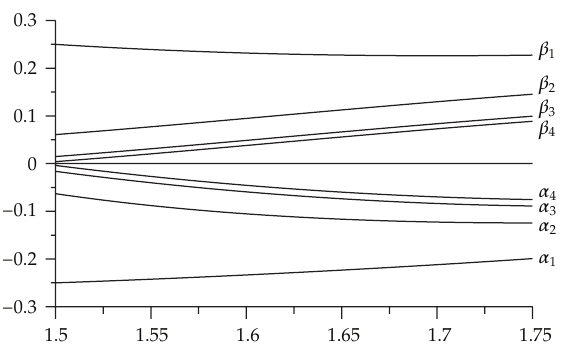
Figure 1: (cid:3) graphs of α k (cid:3) t (cid:6) and β k (cid:3) t (cid:7) . 85 (cid:6) , k (cid:8) 1 , 2 , 3 , 4 (cid:6)